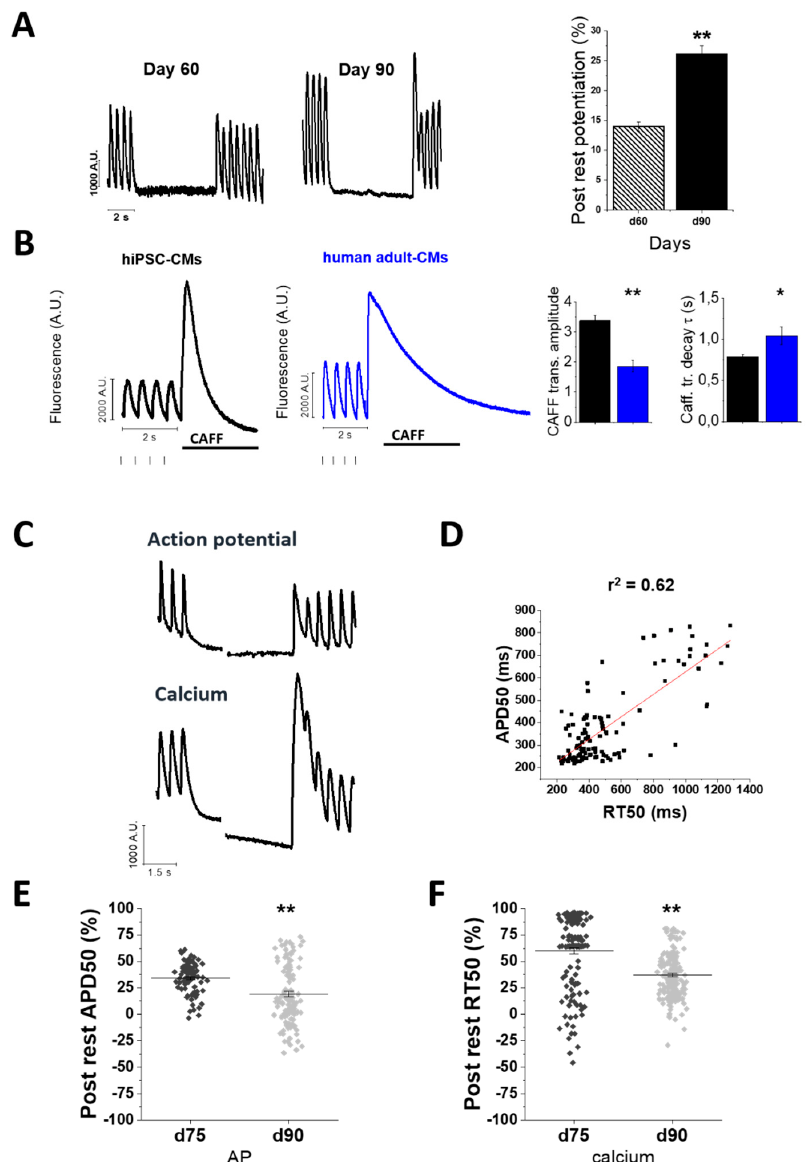
Figure 4. Sarcoplasmic reticulum contribution during hiPSC-CM maturation. Sarcoplasmic reticulum (SR) contribution in calcium handling maturation was tested by a post rest potentiation protocol and caffeine- induced CaTs elicited in hiPSC-CMs at multiple maturation time-points. ( A ) The post-rest potentiation of CaT amplitude was estimated after a resting pause of 5 s, inserted in a regular train of stimulation at 2 Hz. The potentiation is expressed as the % increase of CaT amplitude at the first post-rest beat from that of the last calcium transient before the pause (%). Post rest potentiation is estimated at day 60 and day 90. ( B ) Caffeine-induced CaTs (quick exposure to 10 µM caffeine) after a series of 2 Hz paced CaTs. Average of caffeine transient amplitude was normalized by the amplitude of steady-state calcium transients at 2 Hz prior to caffeine exposure ( N = 2; n = 83). Caffeine transient CaT amplitude (CaT A CAFF /CaT A 2Hz ratio) and decay ( τ , s − 1 ) of hiPSC-CMs were calculated and compared with caffeine-CaT recorded in hAdult-CMs ( N = 5; n = 14). ( C ) Simultaneously recorded APs and CaTs during the pause protocol. ( D ) APs and CaTs from the same cells were compared to show Pearson’s correlation ( r 2 ) between post rest AP duration (APD50, ms) and post rest CaT decay (RT50, ms, p < 0.05). ( E ) Variations of post rest APD50 and ( F ) post rest RT50 were measured both at day 75 (AP: N = 2, n = 119; CaT: N = 5, n = 251) and day 90 (AP: N = 2, n = 119; CaT: N = 3, n = 165). One-way analysis of variance (ANOVA) with a Tukey post-hoc test with statistical significance set at * p < 0.05 and ** p < 0.01 ; NS not significant. Supporting information is reported in Table S2. N = number of differentiations or patients; n = cells.